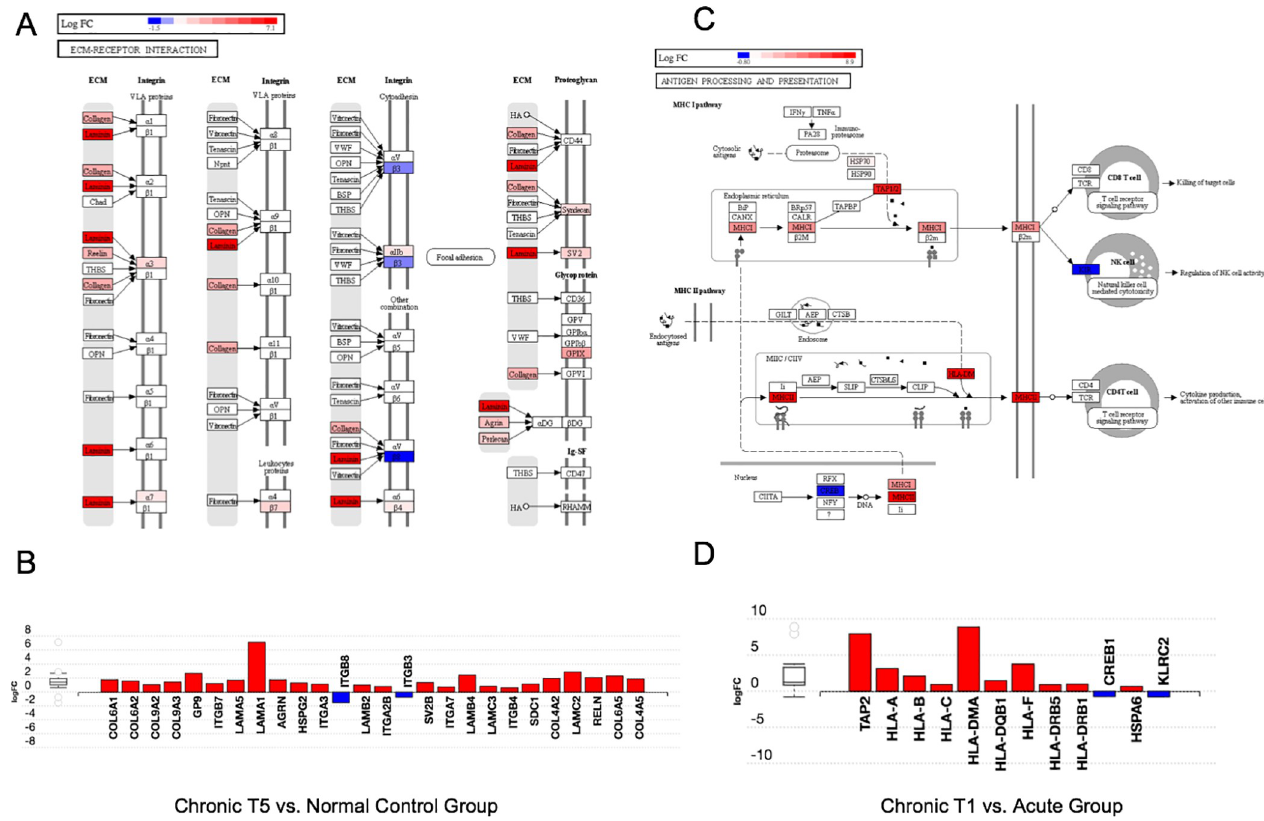
Fig 3. Unbiased pathway analysis demonstrates significant enrichment for extracellular matrix genes in chronic T5 versus the normal control group and the antigen presentation pathway (MHC class I and II) genes in the chronic T1 patients compared with the acute group. Using the Impact Analysis method in iPathway (Advaita Corporation), we conducted unbiased pathway analysis. Each pathway diagram is overlayed with the computed perturbation of each gene. The perturbation accounts both for the gene’s measured fold change and for the accumulated perturbation propagated from any upstream genes (accumulation). The highest negative perturbation is shown in dark blue, while the highest positive perturbation is shown in dark red. The legend describes the values on the gradient in logFC. Note: For legibility, one gene may be represented in multiple places in the diagram and one box may represent multiple genes in the same gene family. A gene is highlighted in all locations it occurs in the diagram. For each gene family, the color corresponding to the gene with the highest absolute perturbation is displayed. (A) Top differentially regulated pathway in the chronic T5 versus normal group is extracellular matrix (ECM)- receptor interaction (KEGG: 04512; p = 0.005). (B) Bar graph of individual gene display for the ECM-receptor interaction pathway. The signed perturbation is represented with negative values in blue and positive values in red. The box and whisker plot on the left summarizes the distribution of all gene perturbations in this pathway. The box represents the 1st quartile, the median and the 3rd quartile, while circles represent the outliers. (C) Top differentially regulated pathway in the chronic T1 versus acute group is antigen processing and presentation (KEGG: 04612; p = 0.006). (D) Bar graph individual gene display for the antigen processing and presentation pathway. The signed perturbation is represented with negative values in blue and positive values in red. The box and whisker plot on the left summarizes the distribution of all gene perturbations in this pathway. The box represents the 1st quartile, the median and the 3rd quartile, while circles represent the